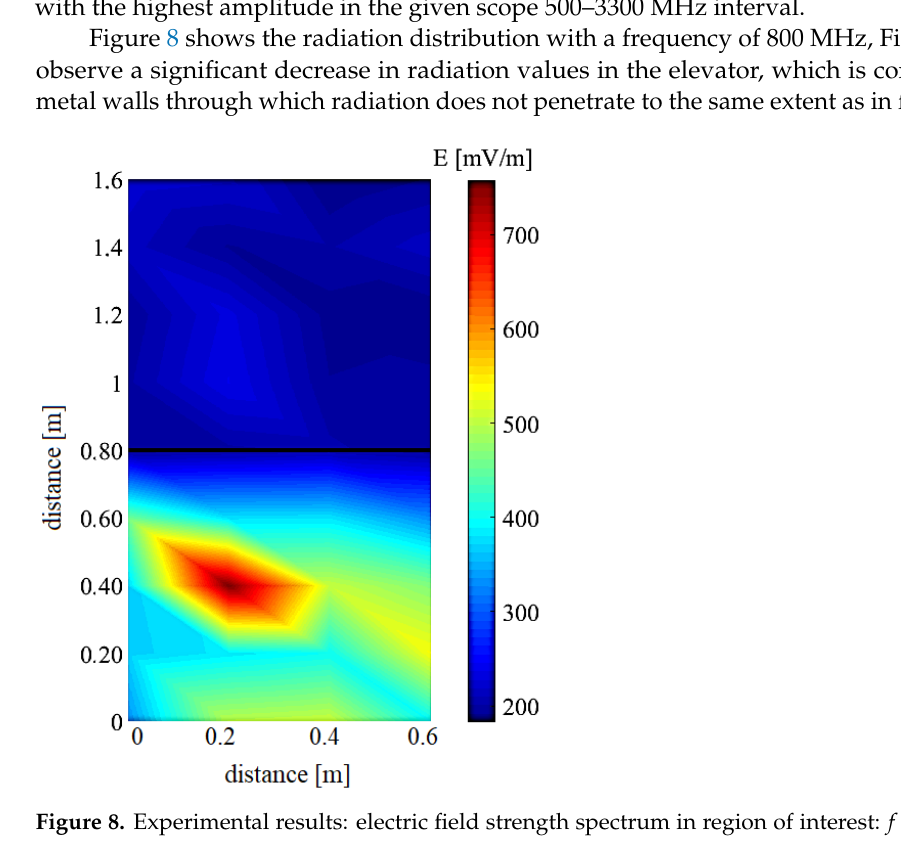
Figure 8. Experimental results: electric field strength spectrum in region of interest: f = 800 MHz. The line shows the border corridor/elevator.